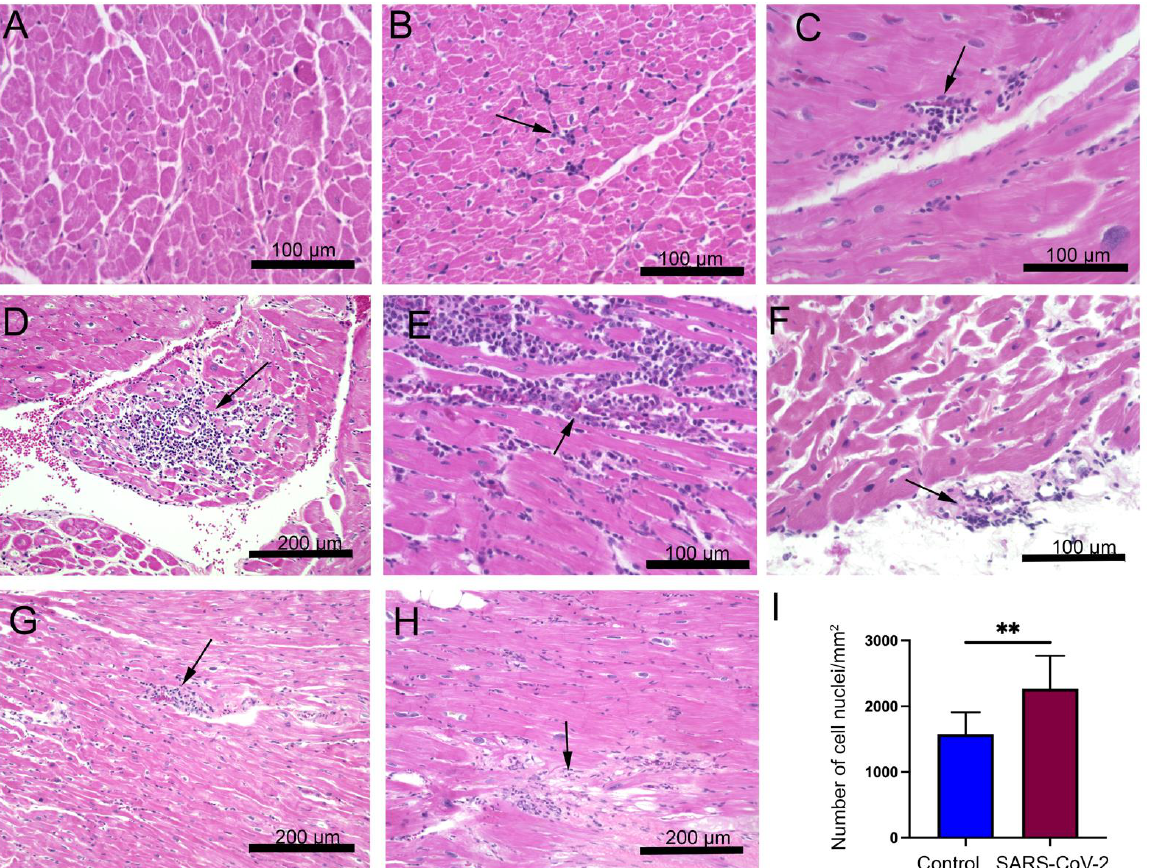
Figure 1. Myocardial lesions are present in the left ventricular cardiac tissue of severe acute respi- ratory syndrome coronavirus 2 (SARS-CoV-2) infected monkeys. Four adult-aged African green monkeys (AGMs) and four rhesus macaques (RMs) were inoculated with the SARS-CoV-2 virus (day 0) and observed for up to 28 days at the time of necropsy. Healthy monkey hearts ( n = 8) were used for control. Representative microscopy images show hematoxylin and eosin staining in ( A ) control and ( B – H ) SARS-CoV-2 infected hearts (the blue color represents nuclei). ( B , C , E ) Varying degree of focal mononuclear infiltrates of inflammatory cells with and without necrosis were localized in the intersti- tium (arrows). ( F ) Focal lymphocytic cells were detected in the pericardium (arrow). ( D , G ) Varying degrees of perivascular inflammation manifested in infected monkeys (arrows). ( H ) Myocardial inflammatory cells were associated with areas of tissue degeneration (arrow). ( I ) The graph shows quantification of cellular nuclei in control and SARS-CoV-2 infected hearts (**, p -value < 0.01). Scale bars: 200 µ m ( D , G , H ); 100 µ m ( A–C , E , F